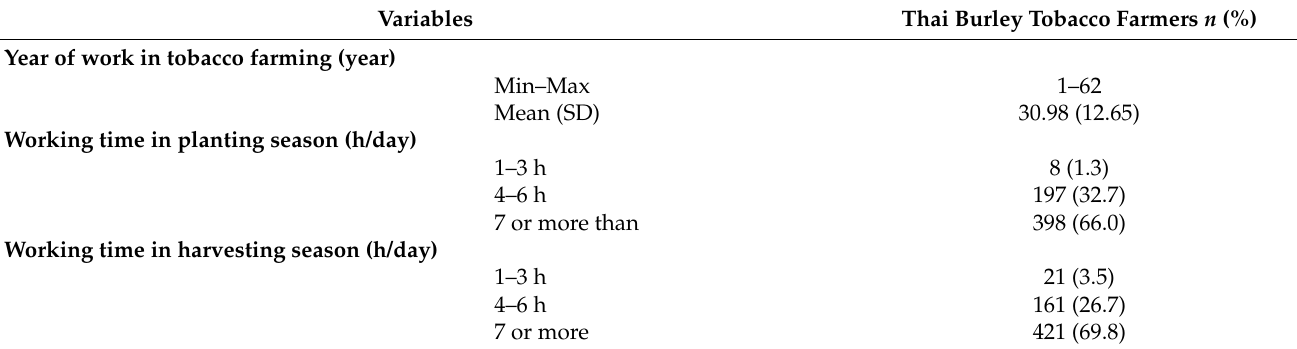
Table 1. Cont. Variables